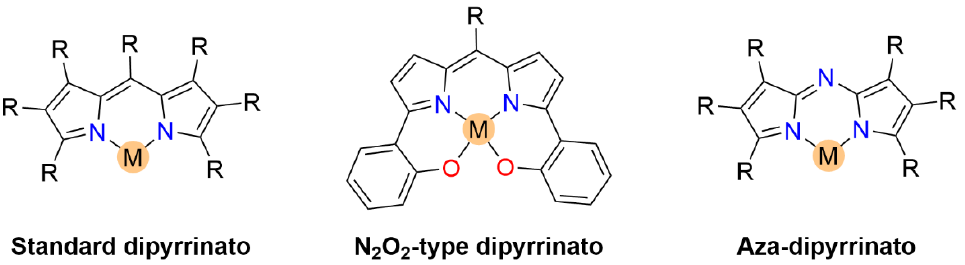
Figure 10. Three different types of dipyrrinato-based complexes with unspecified side groups (R). Nitrogen atoms are depicted in blue; oxygen atoms are depicted in red.